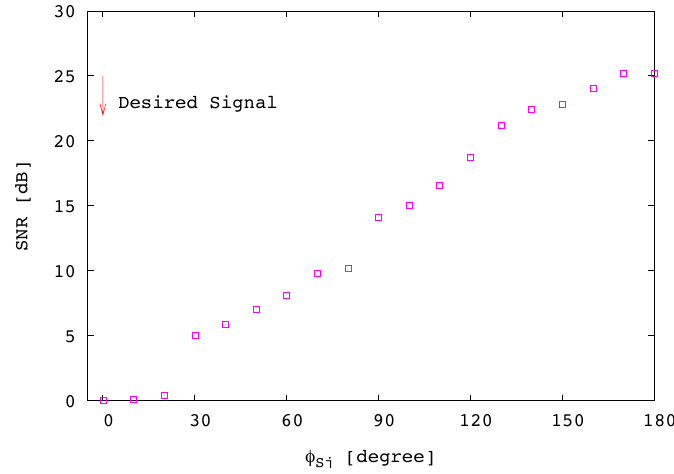
Figure 10. Numerical assessment. Signal-to-noise ratio versus different interfering